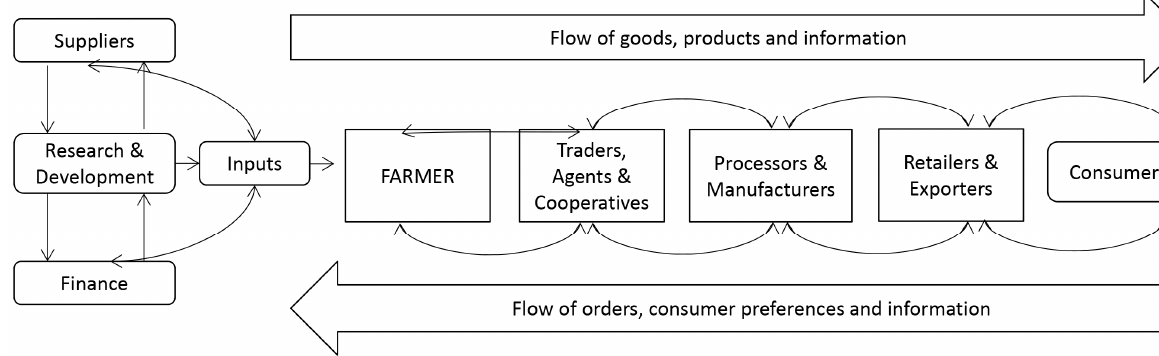
Figure 1. Production to Consumption Value Chain